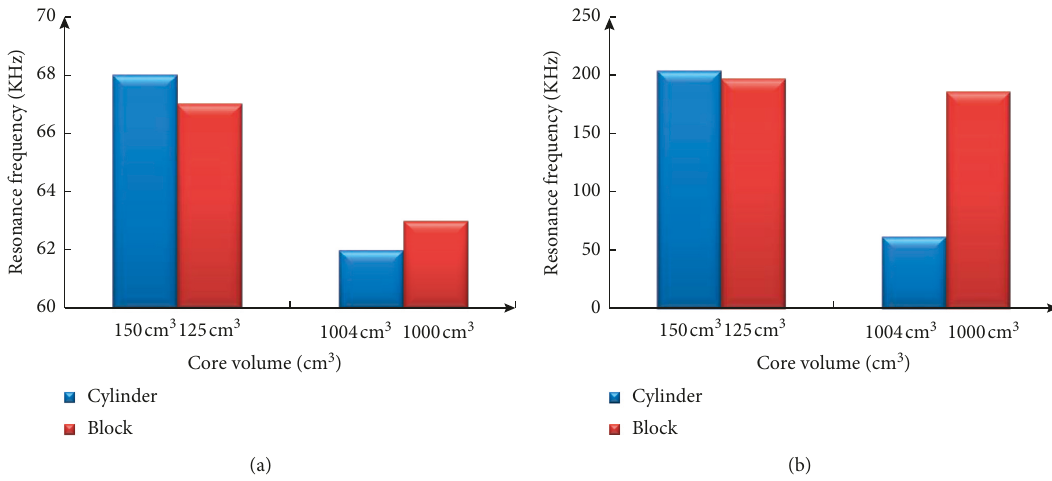
Figure 14: Histograms of resonance frequencies of sandstone cores with different shapes: (a) 50kHz; (b)